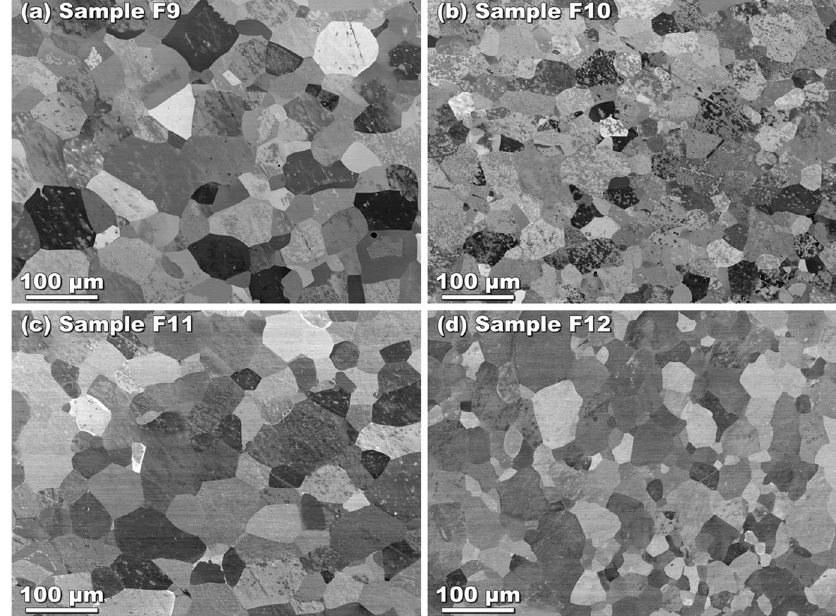
FIG. 4. Representative low magnification BSE images coupon sample surfaces with grain boundaries (GB) after different heat treatments, (a) 800 °C = 3 h with no nitrogen infusion and (b) – (d) are low temperature nitrogen infused at 120, 140 and 160 °C, respectively.